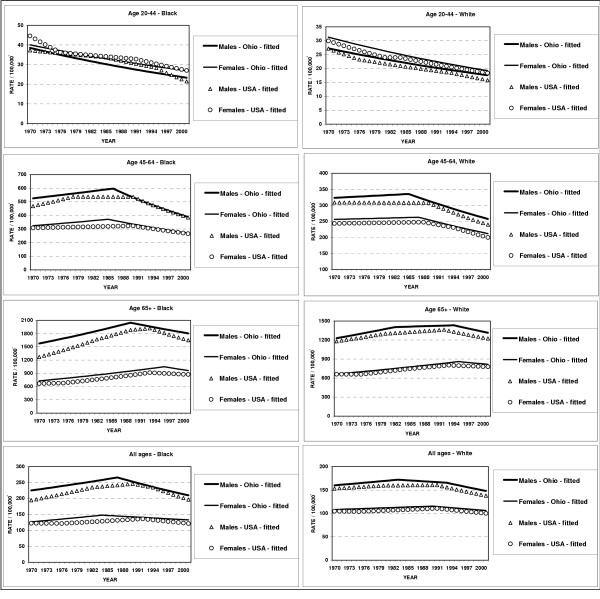
Cancer mortality time trends, all sites, Ohio vs USA, 1970–2001, by race # – Age-adjusted mortality rates (World Standard Population).